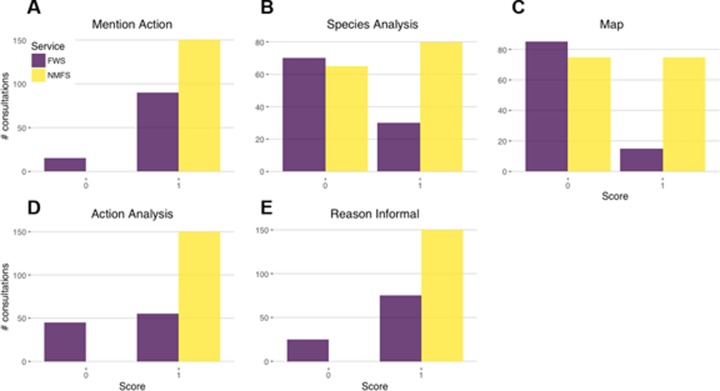
Informal consultations from NMFS featured more information and therefore showed higher completeness scores than those from FWS on average.The components of informal consultation completeness scores were binary (0 indicates absence; 1 indicates presence) in the consultations.